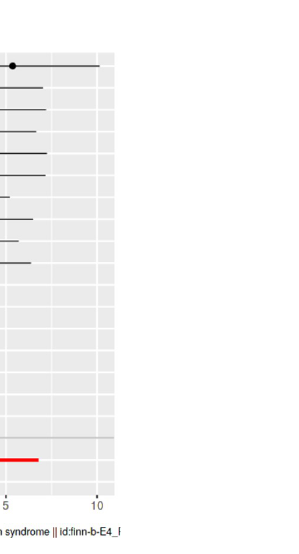
Fig 8. Forest plot of hip circumference, against polycystic ovarian syndrome as the outcome. Effects of individual SNPs and pooled estimates from MR-Egger- and inverse variance weighted methods are visualized.